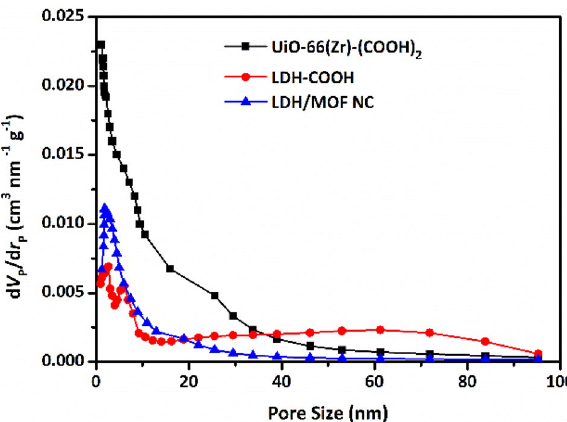
Figure 5. BJH pore size distribution of the